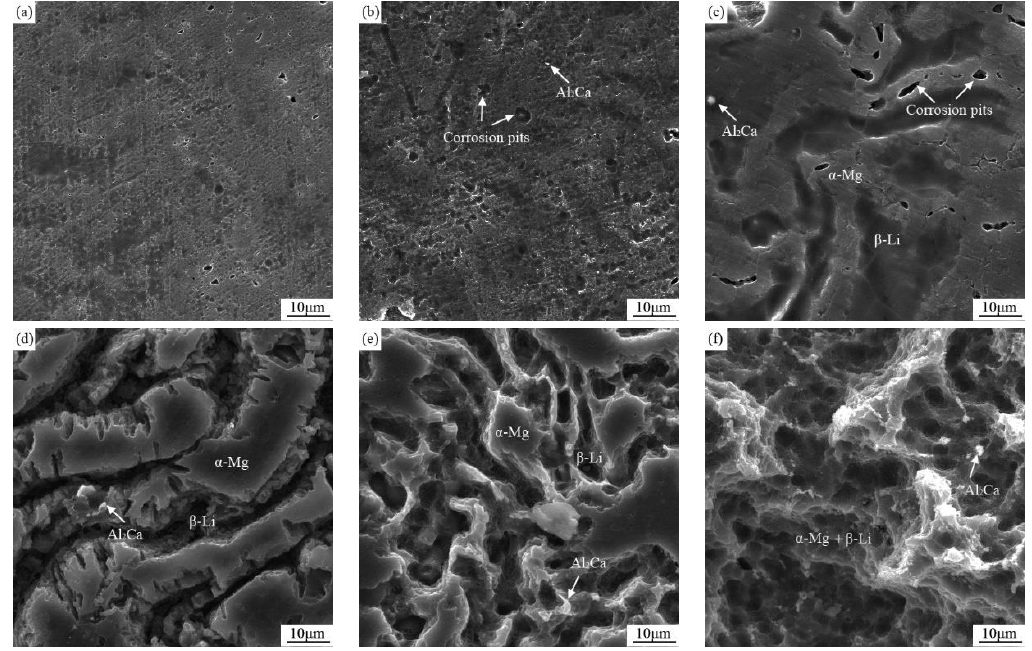
Figure 13. Micrographs showing corrosion at different times in the extruded Mg–7Li–3A–0.4Ca alloy after immersion in a 3.5 wt.% NaCl solution at 25 °C. ( a ) 6 h ( b ) 12 h ( c ) 24 h ( d ) 48 h ( e ) 60 h ( f ) 72 h.